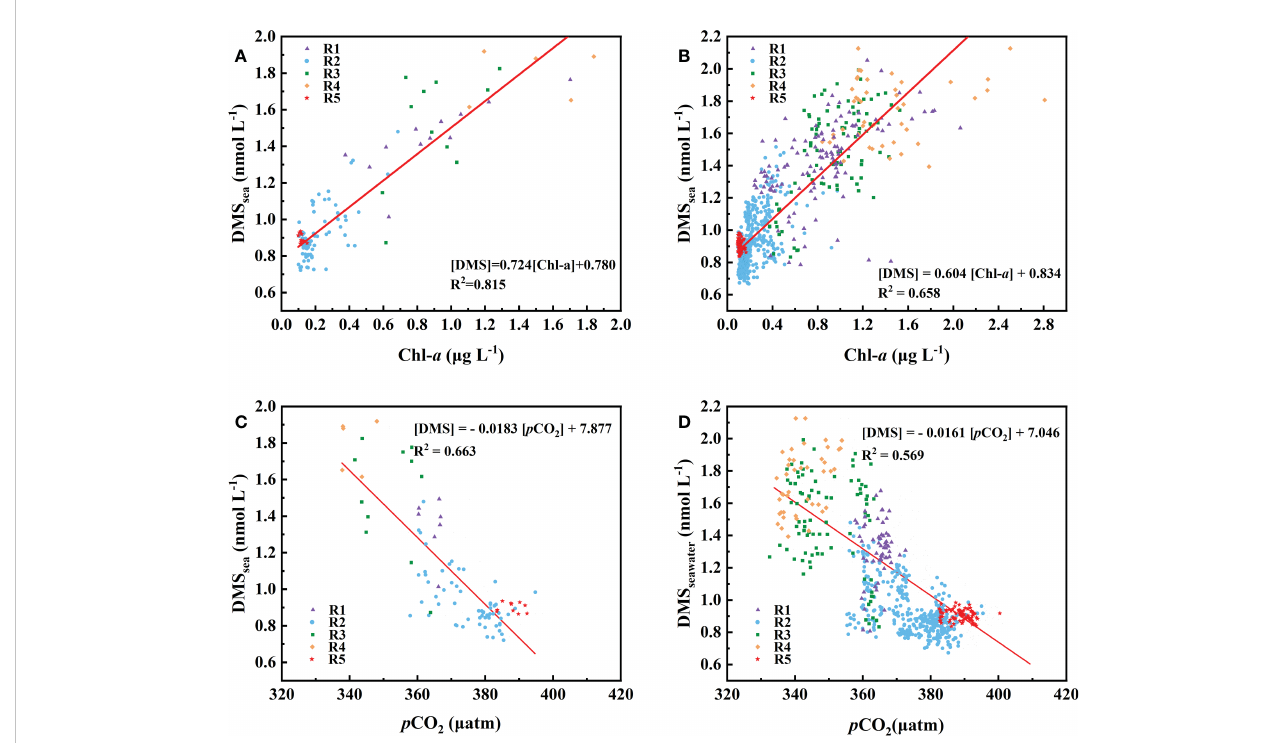
FIGURE 4 Relationship between Chl-a (A, B) and p CO 2 (C, D) with observed DMS concentrations. The data presented are means of (A, C) 1° and (B, D) 0.1° grids.